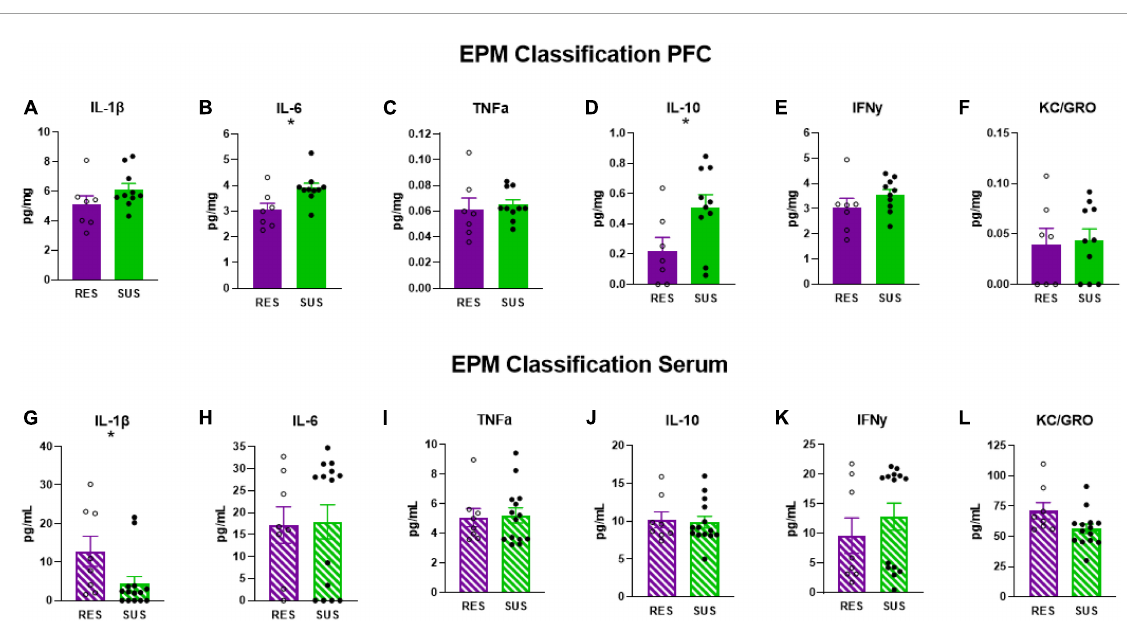
but not serum, before trauma compared to Res rats which supports the hypothesis that neuroinflammation, rather than peripheral inflammation, is a susceptibility factor. We also found a tendency, albeit not significant, of higher serum levels of IL- 1 β , IL-6, and TNF α in Res rats compared to Sus before trauma ( Figures 2G–I ). This may be residual inflammation from the mild stressor exposure (cat hair) and/or ASR and EPM tests that are required in the RISP model for classification (Nalloor et al.,